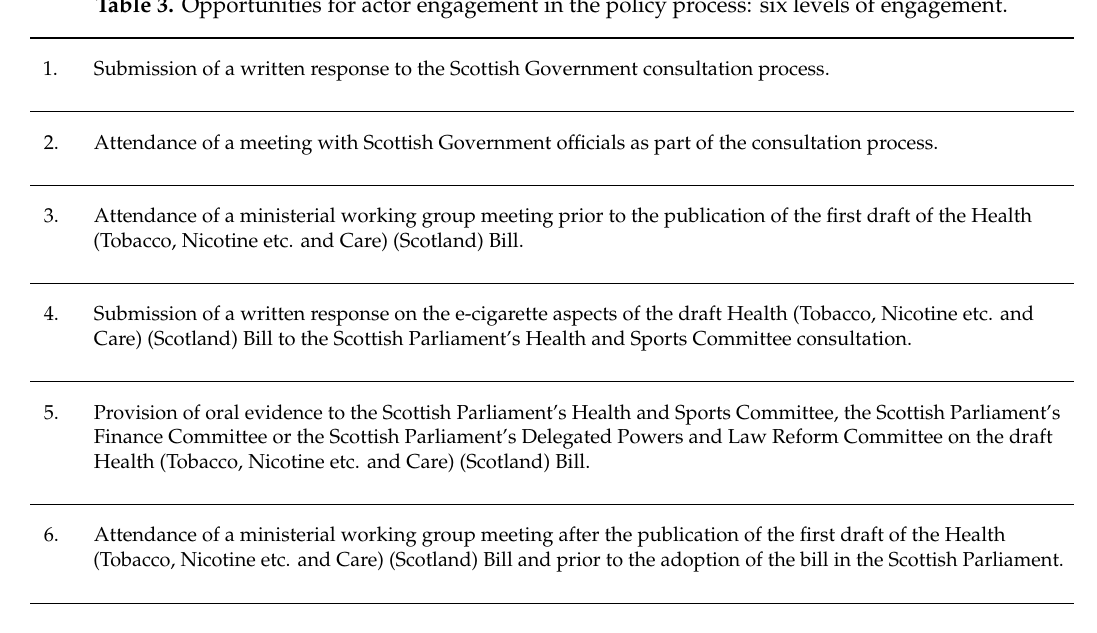
Table 3. Opportunities for actor engagement in the policy process: six levels of